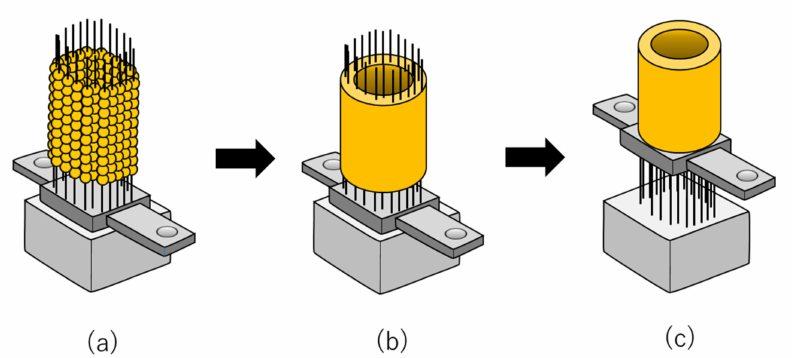
Figure 3. The fabrication of sca ff old-free AT-MSC constructs using the “Kenzan”. ( a ) Spheroids are skewered onto the “Kenzan” automatically using a bio-3D printer and employed to fabricate sca ff old-free tubular cell constructs. ( b ) Spheroids are cultured on the microneedles of the “Kenzan” to fuse with each other. ( c ) The sca ff old-free cell construct is retrieved from the “Kenzan” and additionally cultured on tubular support for further maturation.